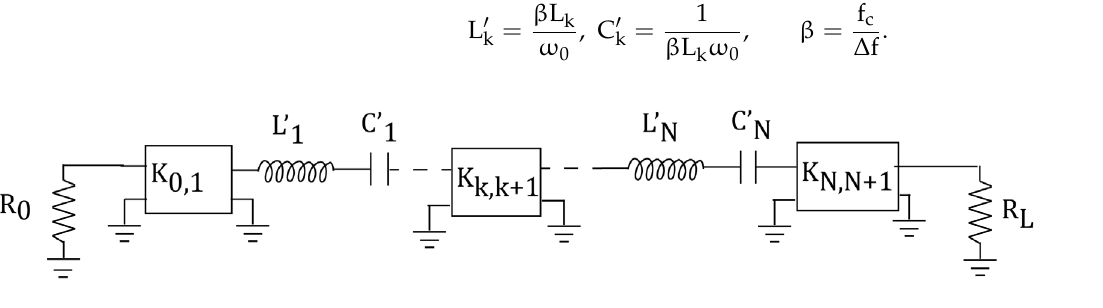
Figure 3. Bandpass filter prototype.